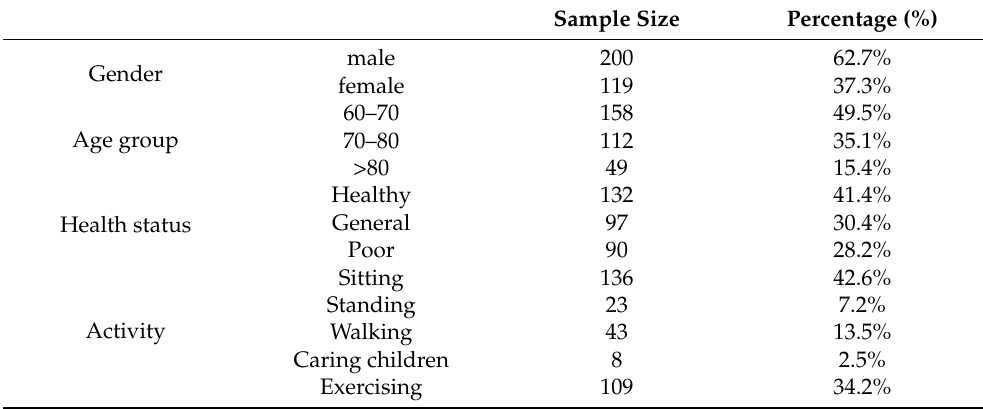
Table 3. Respondent